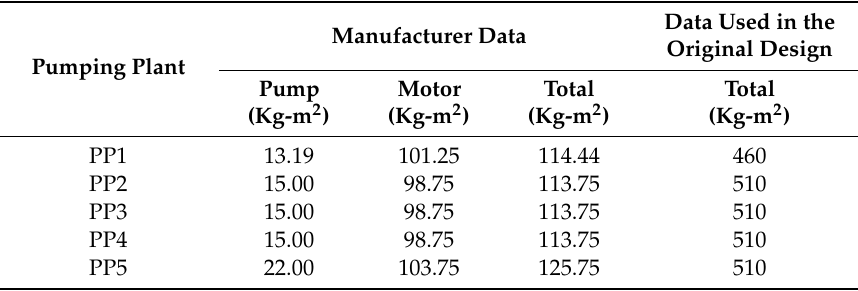
Table 2. Moment of inertia of the